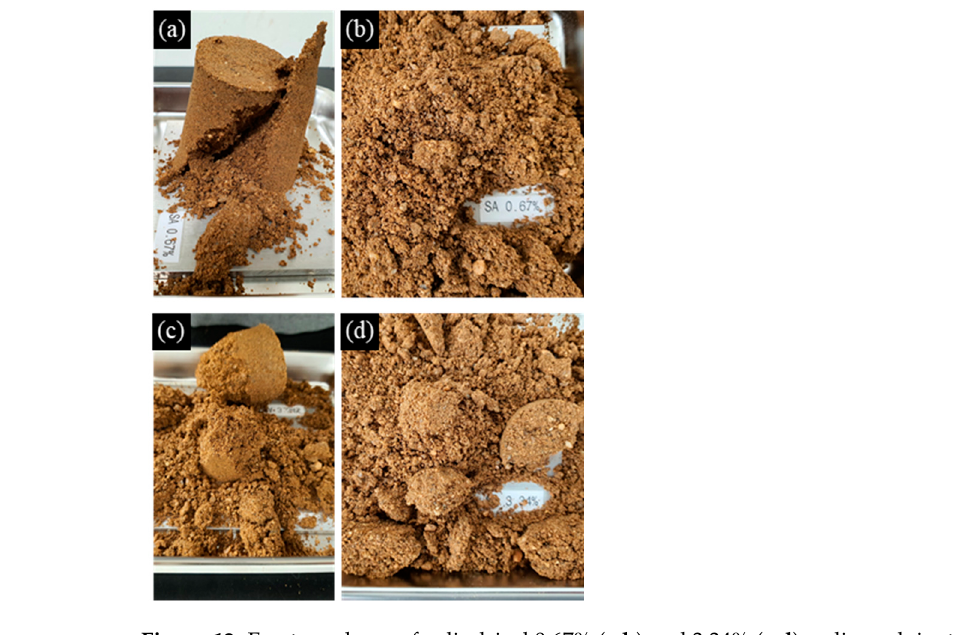
Figure 12. Fracture shape of cylindrical 0.67% ( a , b ) and 3.34% ( c , d ) sodium alginate (SA) rein-